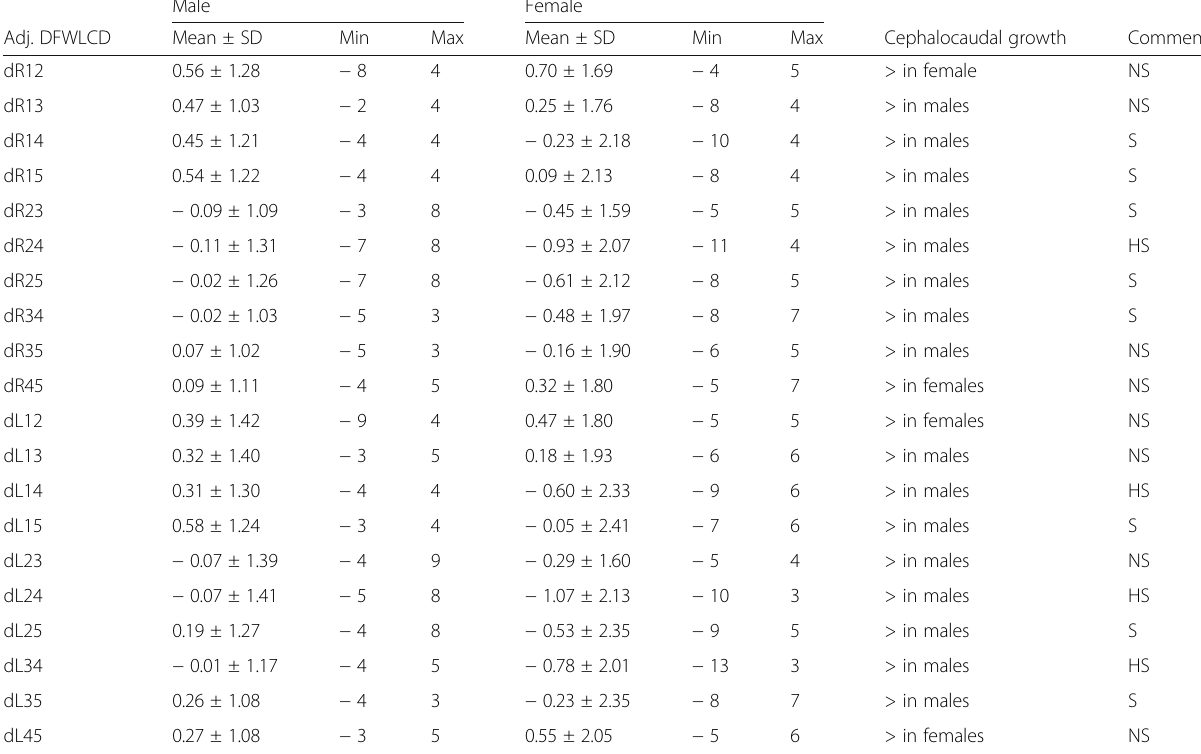
Table 2 Descriptive statistics adj. DFWLCD and sexual dimorphism in cephalic to caudal growth inhibition in the right and left sides of the